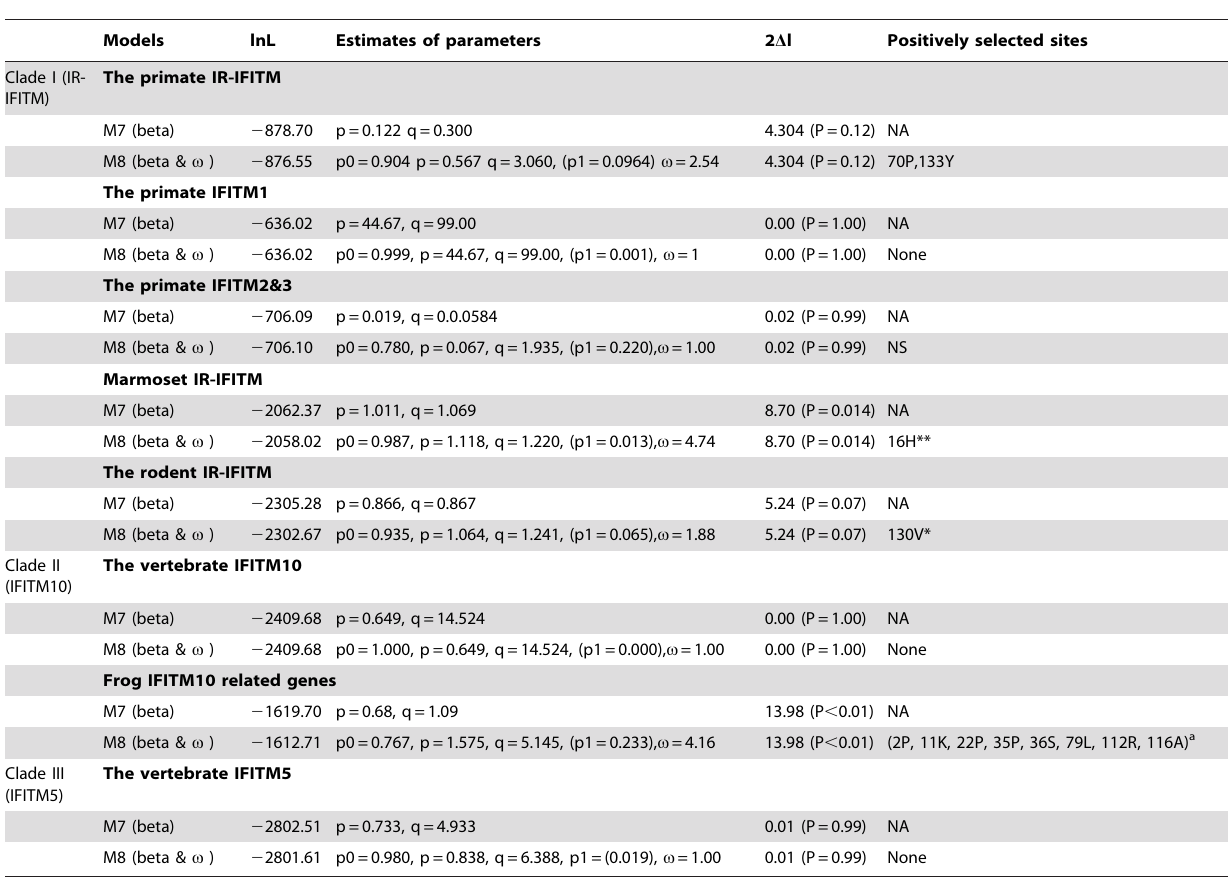
Table 3. Site-specific tests for positive selection on different IFITM